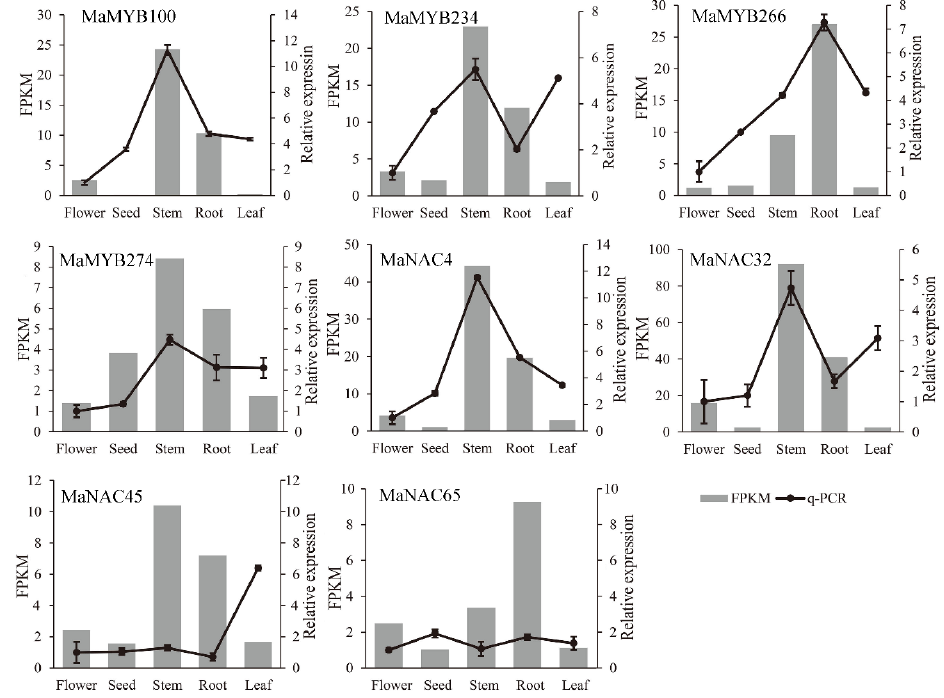
Figure 10. Expression of NAC and MYB lignin biosynthesis-related genes determined by qRT-PCR in flower, seed, stem, root and leaf. The shown values are the means ± standard deviation of three replicates. MaTublin was used as the reference gene.